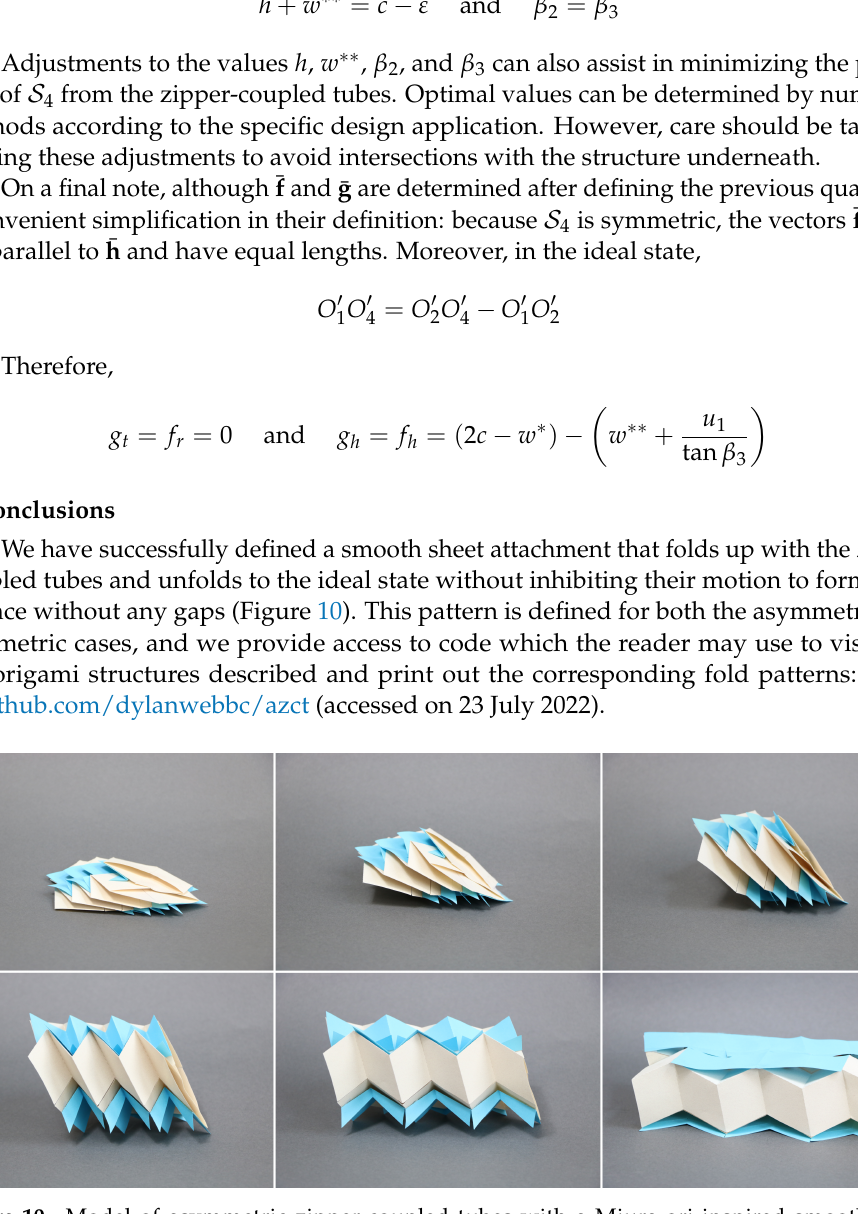
π , α 2 = 5 π , a = b = c . 3 9